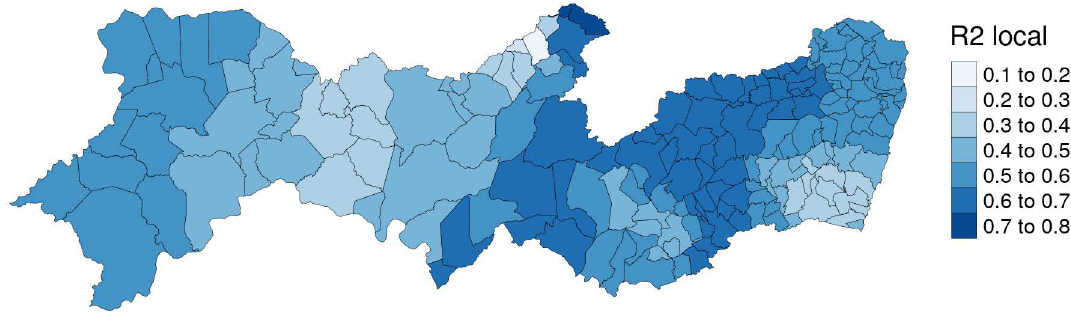
Figure 6. Distribution of local R 2 for the GWR